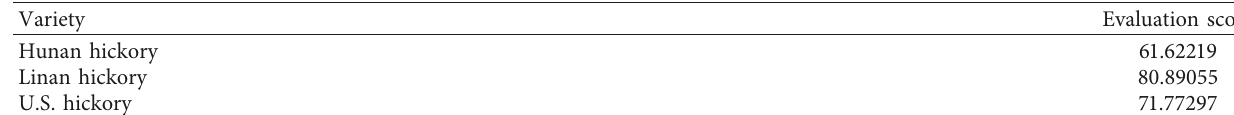
Figure 1: The weights of 21 indexes of three kinds of hickories with single nutrient component. Table 4: Scores considering nutrient and texture.